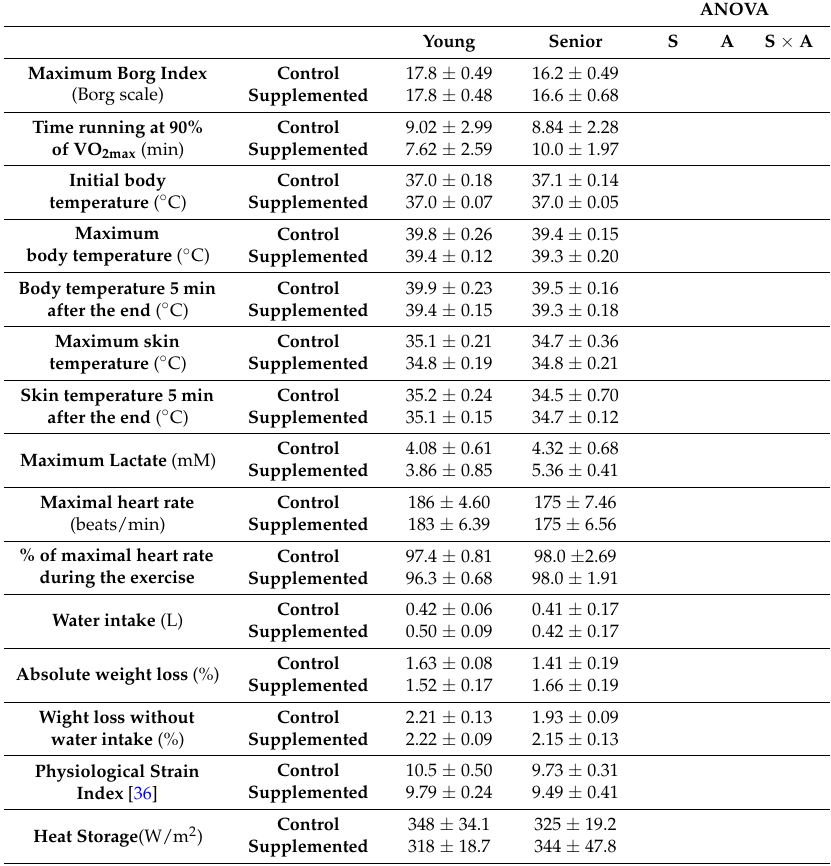
Table 4. Effects of Age and dietary beverage supplementation on stress